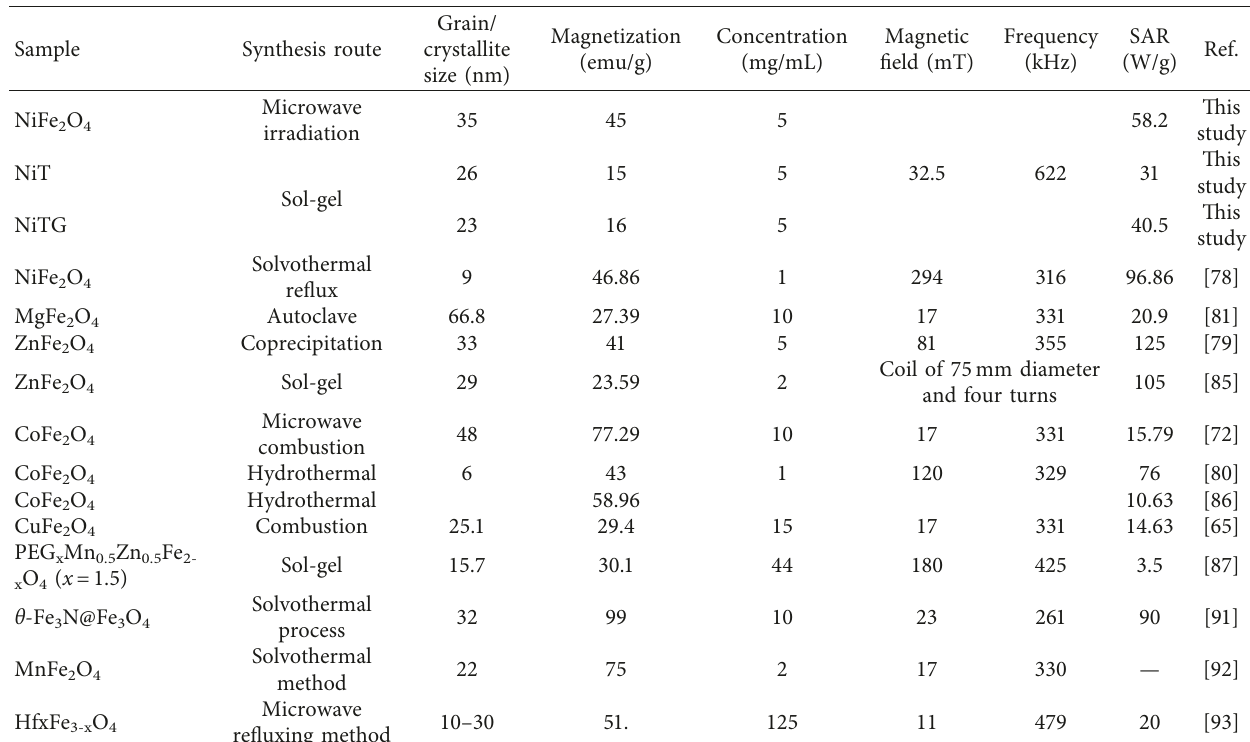
Table 4: Comparative study of the present work with previous literature.